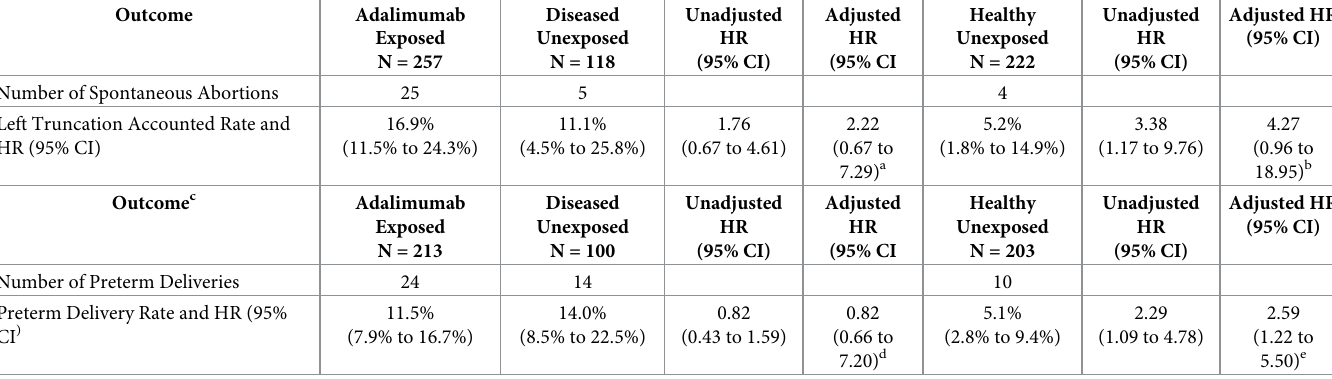
Table 4. Estimated probabilities of spontaneous abortion and preterm delivery in pregnant women exposed to adalimumab compared to women not exposed, 2004–2016.